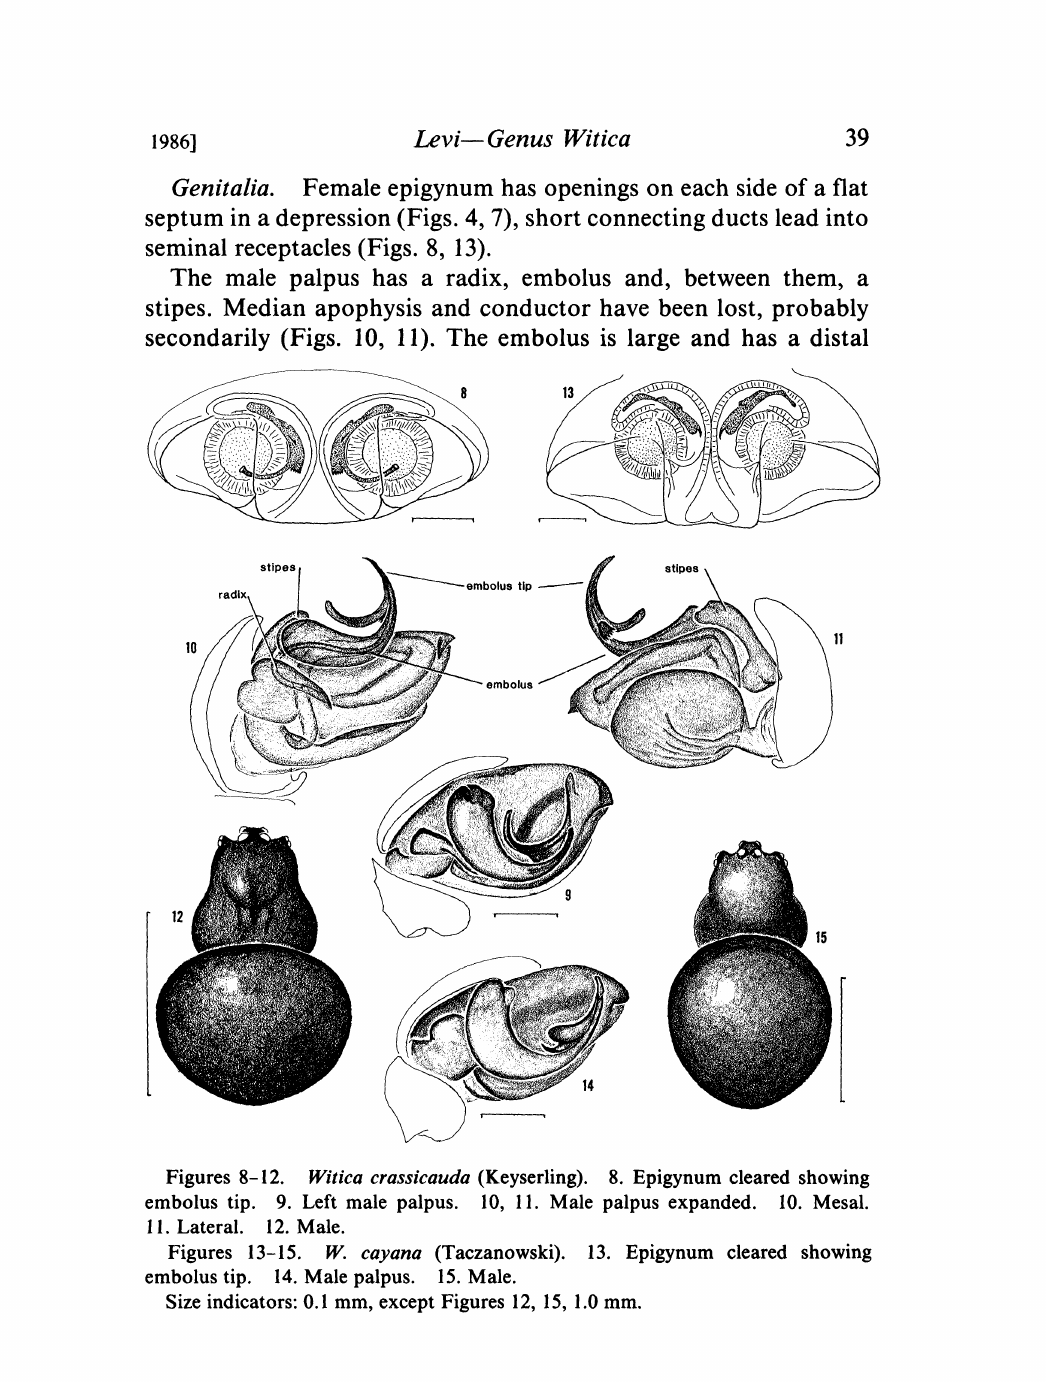
Figures 8-12. Witica crassicauda (Keyserling). 8. Epigynum cleared showing embolus tip. 9. Left male palpus. 10, 11. Male palpus expanded. 10. Mesal. 11. Lateral. 12. Male. Figures 13-15. Size indicators: 0.1 mm, except Figures 12, 15, 1.0